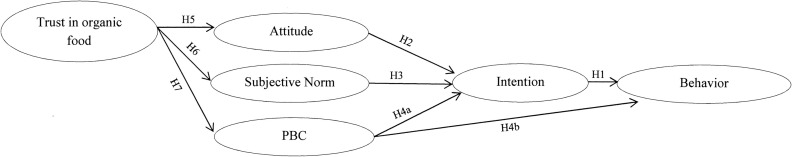
Hypothesized model. PBC, Perceived Behavioral Control.